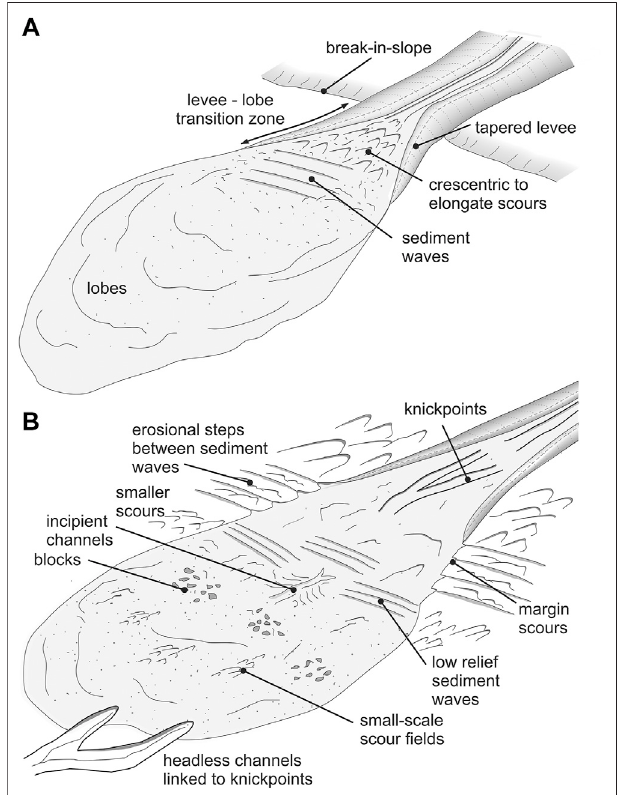
FIGURE 1 | Cartoons of end member channel mouth settings. (A) A channel-lobe transition zone, based on Wynn et al. (2002a) and Brooks et al. (2018). Note the transition from scours to sediment waves downstream of the channel mouth. (B) A channel mouth expansion zone (CMEZ) based on Maier et al. (2020). Note the scours and sediment waves inside and outside the area where the channel mouth fl ares